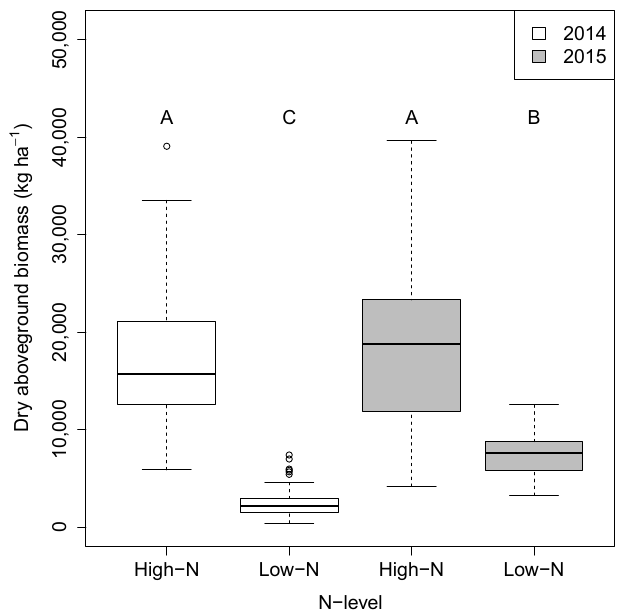
Figure 1. Changes in dry aboveground biomass between plants grown at different N levels. Box plots of the dry aboveground biomass (Kg ha − 1 ) of all genotypes planted in the high- and low-N fields in 2014 and 2015. Different letters indicate significant differences according to Tukey test ( p < 0.05).